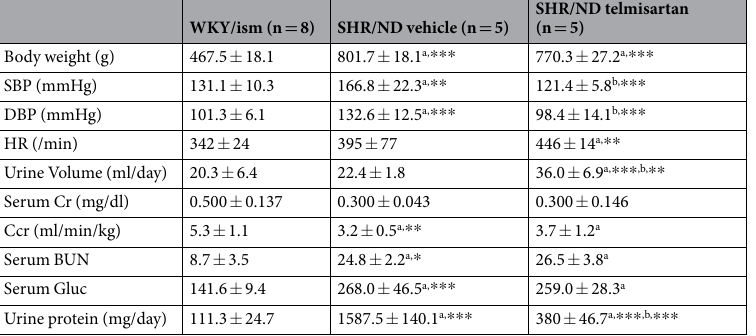
SHR/ND telmisartan (n = 5)